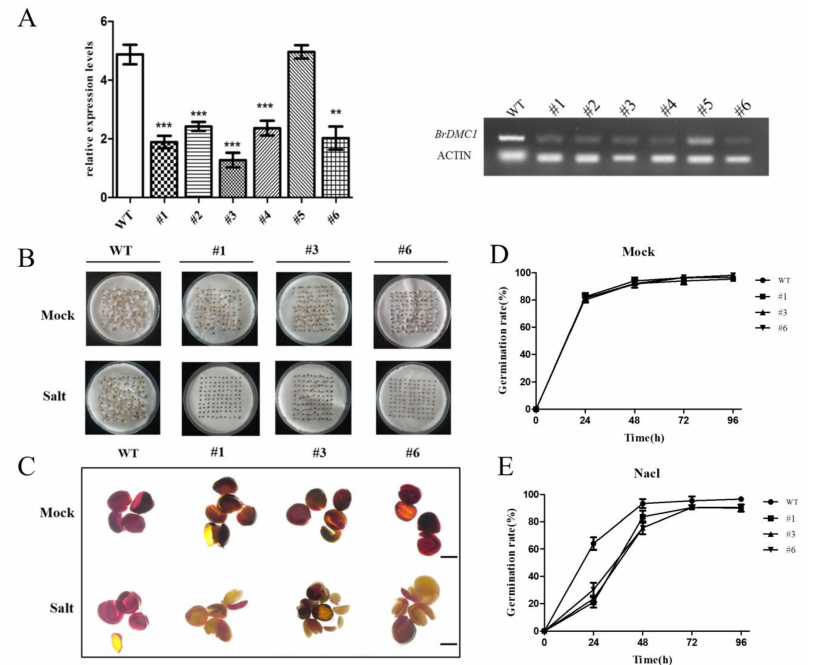
Figure 5. BrDMC1 -RNAi decreased salt tolerance during seed germination. ( A ) Relative expression level confirmation of the BrDMC1 gene in BrDMC1 -RNAi determined via qRT-PCR. ( B ) Phenotypes of WT and BrDMC1 -RNAi seeds in 100 mM NaCl treatment. ( C ) TTC staining analysis seed vigor. ( D ) Statistical analysis of germination rate in mock. ( E ) Statistical analysis of germination rate in 100 mM NaCl. (** p < 0.01 and *** p <